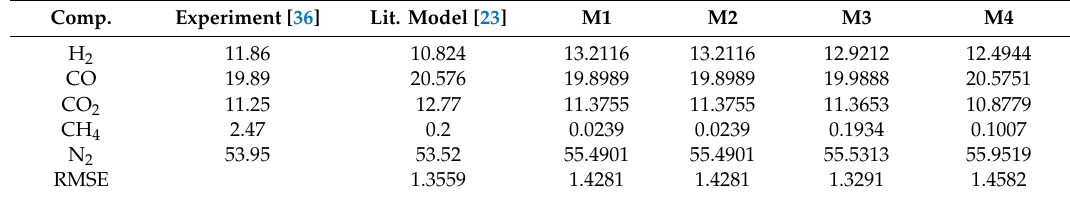
Table 3. Validation of models.